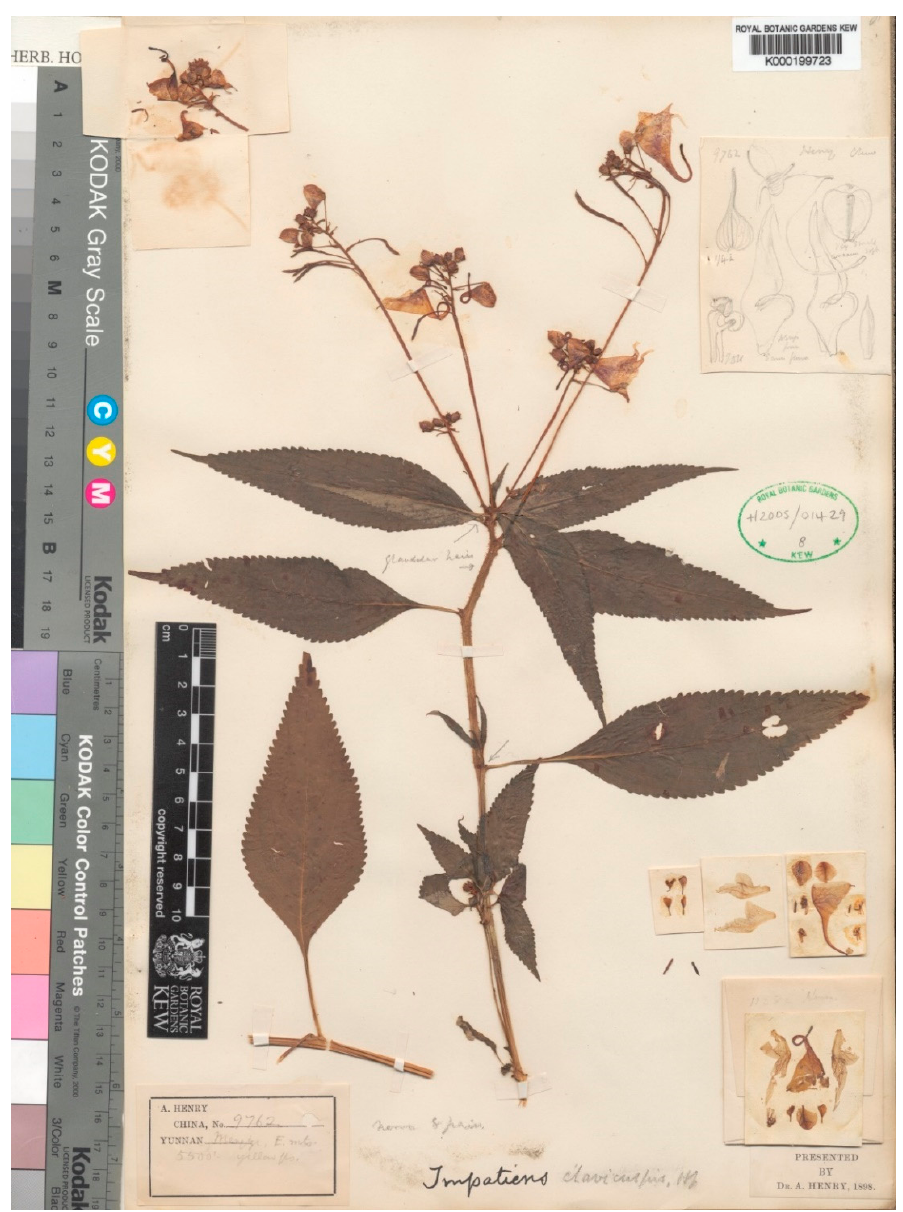
Figure 4. Lectotype of Impatiens clavicuspis Hook. ex W. W. Smith (designated here). Source from http://specimens.kew.org/herbarium/K000199723 (accessed on 6 April 2021). © copyright of